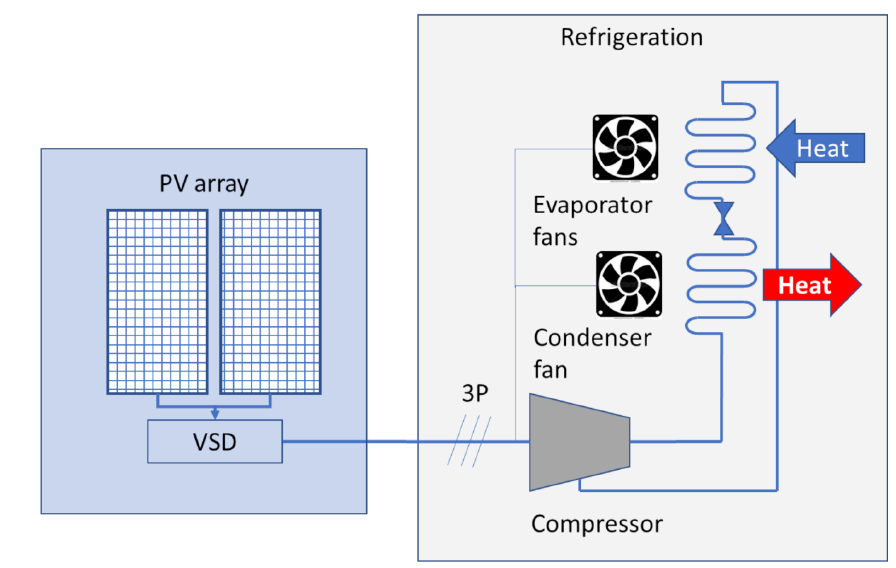
Figure 3. Basic electrical architecture for a solar-powered cold storage